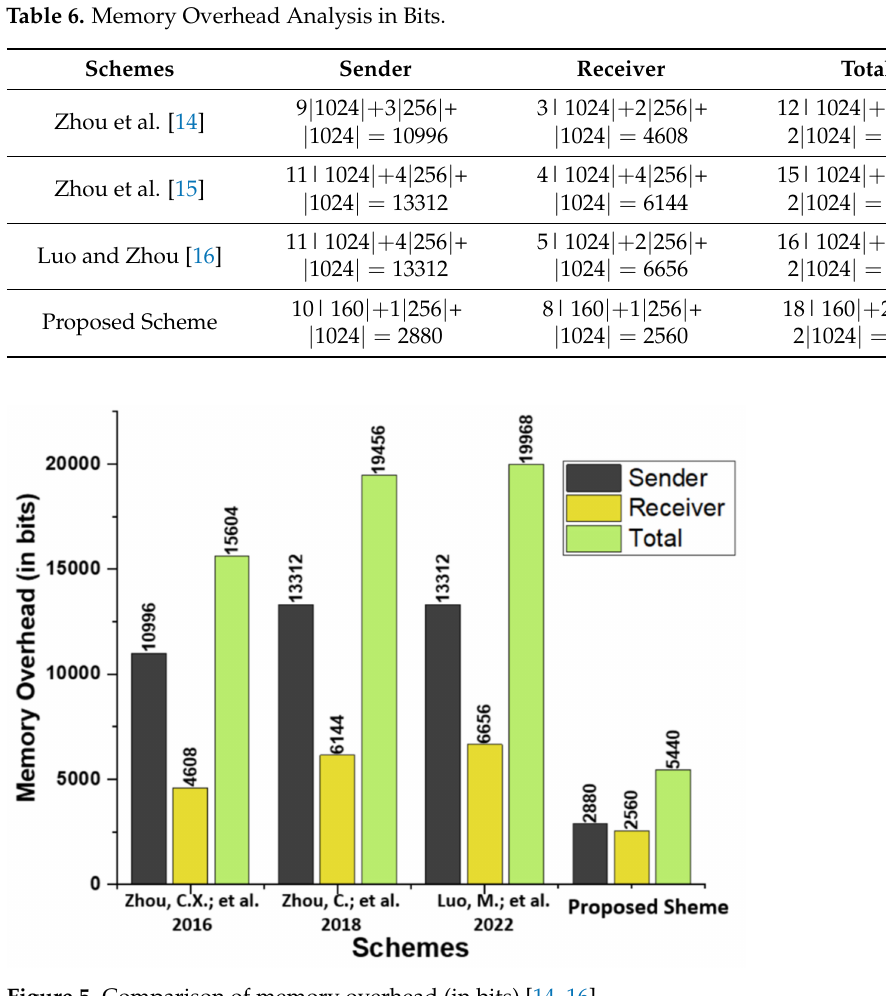
Figure 5. Comparison of memory overhead (in bits)